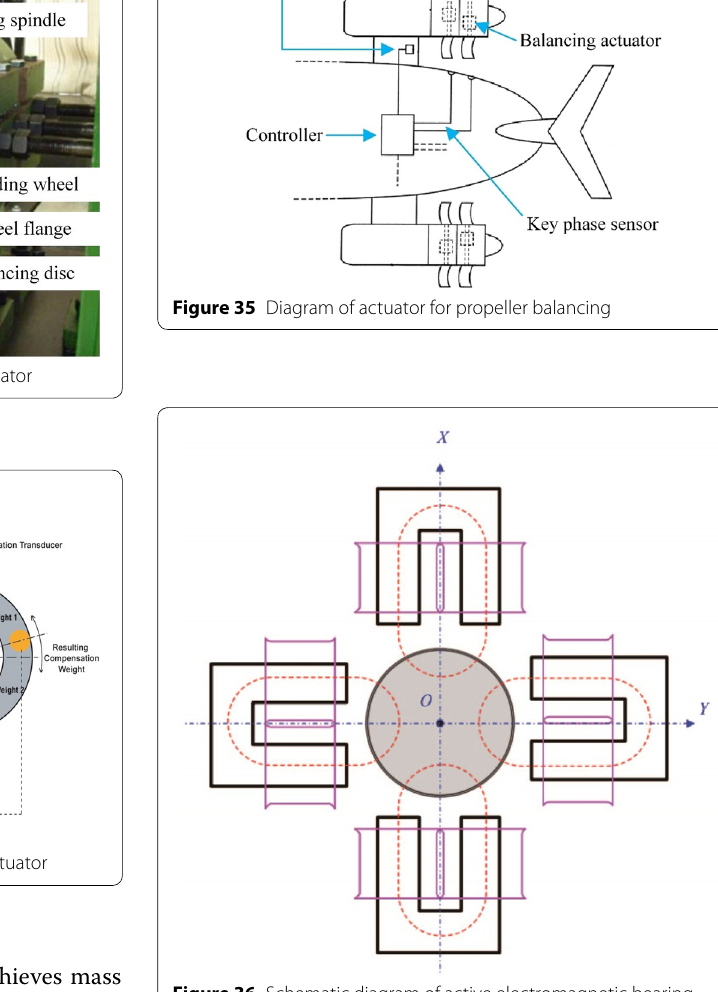
Figure 36 Schematic diagram of active electromagnetic bearing